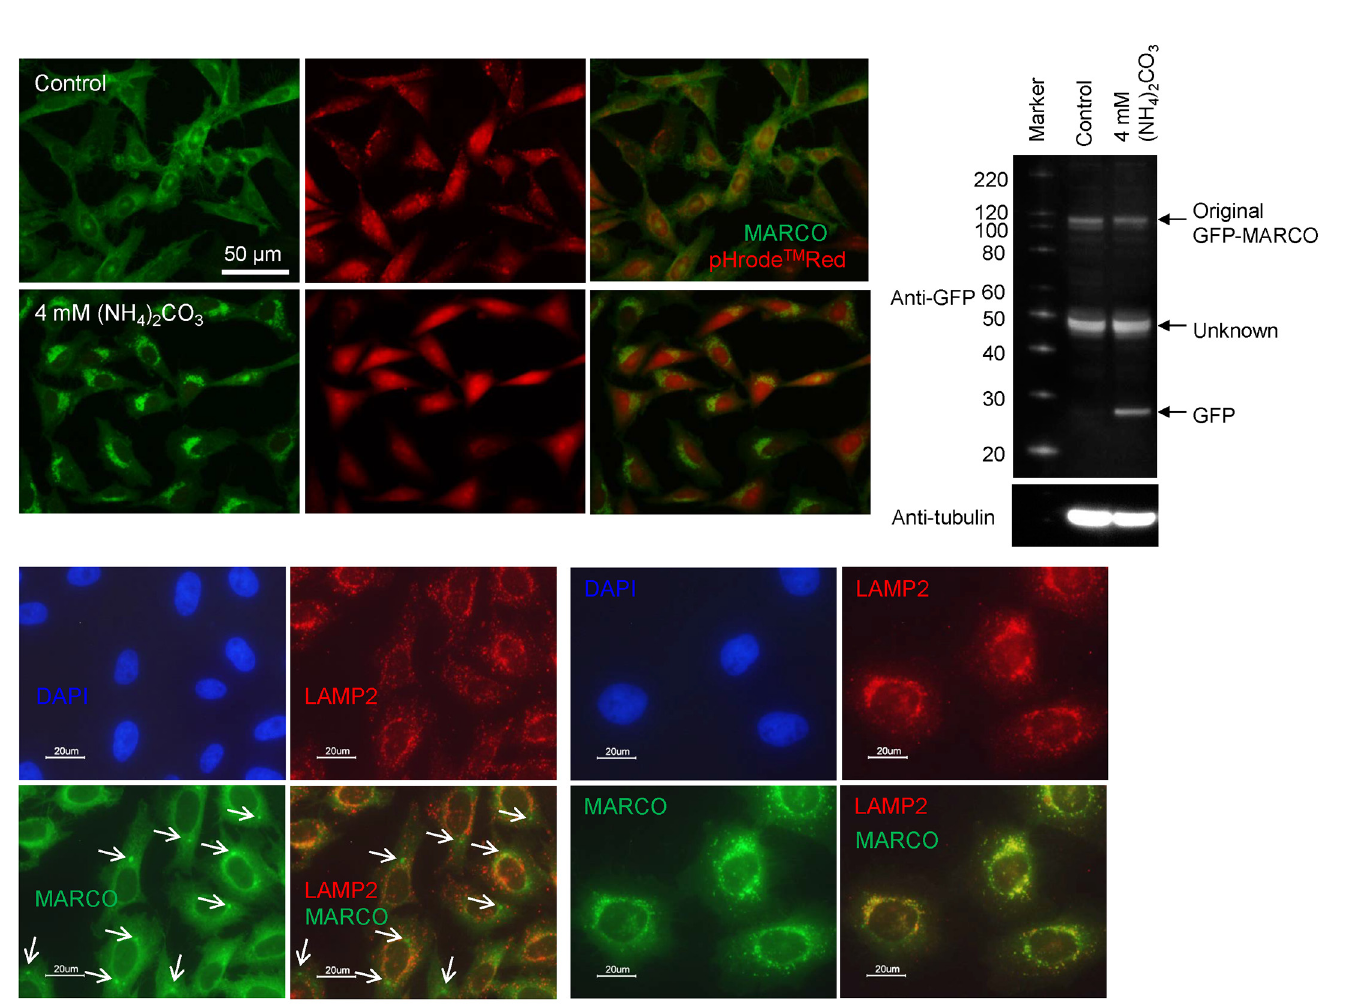
Fig 4. Processing of GFP-MARCO in lysosomes. (A) GFP-MARCO-CHO cells were incubated with or without (NH 4 ) 2 CO 3 and the cells were loaded with pHrode Red AM. The cells were washed and cultured in HEPES-buffered HBSS for 2h. The acidity of lysosomes was neutralized by (NH 4 ) 2 CO 3 . (B) Macropinocytic inclusions (arrows) did not co-localize with lysosomes. The control GFP-MARCO-CHO cells were fixed and stained with anti-LAMP2 antibody (2 nd Ab: Alexa Fluor 1 594-labeled goat anti-mouse IgG). (C) Co-localization of GFP-MARCO and LAMP2 in autophagic puncta. The cells were grown for 15 hr in the presence of 50 μ M chloroquine. See also the legend to Fig 4 (B) for immunofluorescent staining. (D) GFP-MARCO-CHO cells were cultured for 15 hr in fresh F12 medium in the presence or absence (Control) of 4 mM (NH 4 ) 2 CO 3 . The supernatant of the cellular lysate was analyzed by SDS-PAGE followed by western blotting for the detection of GFP. The membrane was reprobed with POD-tagged anti-tubulin to serve loading control.